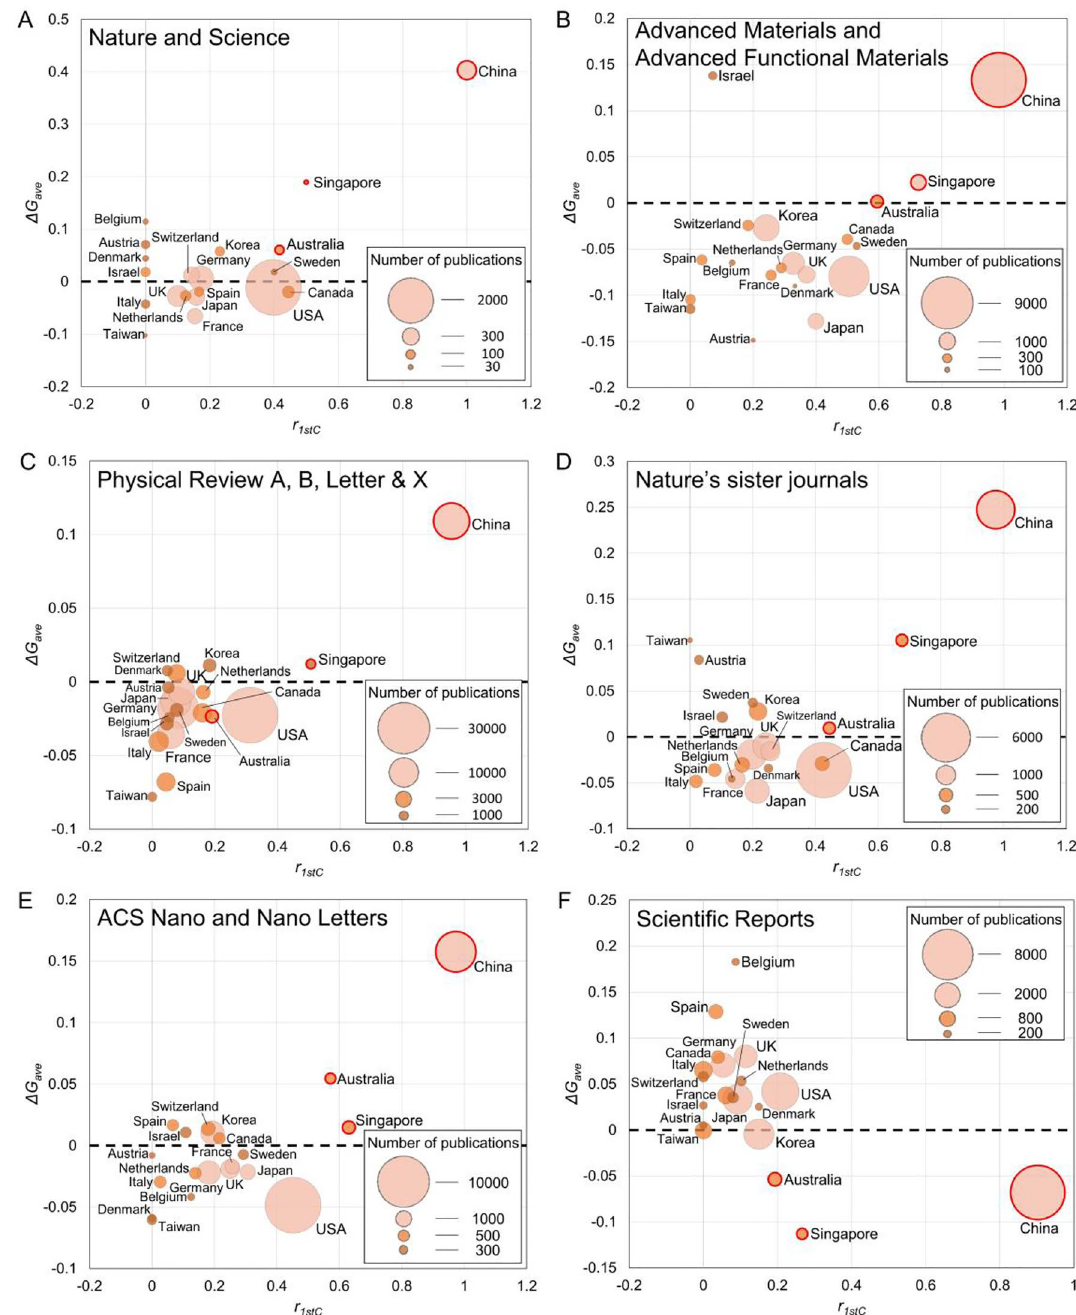
Figure 2. The net publication growth ( ΔG ave ) vs the ratio of Chinese first author ( r 1stC ) in ( A ) Nature and Science, ( B ) Advanced Materials and Advanced Functional Materials, ( C ) Physical Review A, B, Letters, and X, ( D ) Nature’s sister journals, ( E ) ACS Nano and Nano Letters, ( F ) Scientific Reports. The area of the circle denotes the total number of publications from 2010 to 2021 of a country. China, Singapore, and Australia display notable exceptions and are denoted by the red